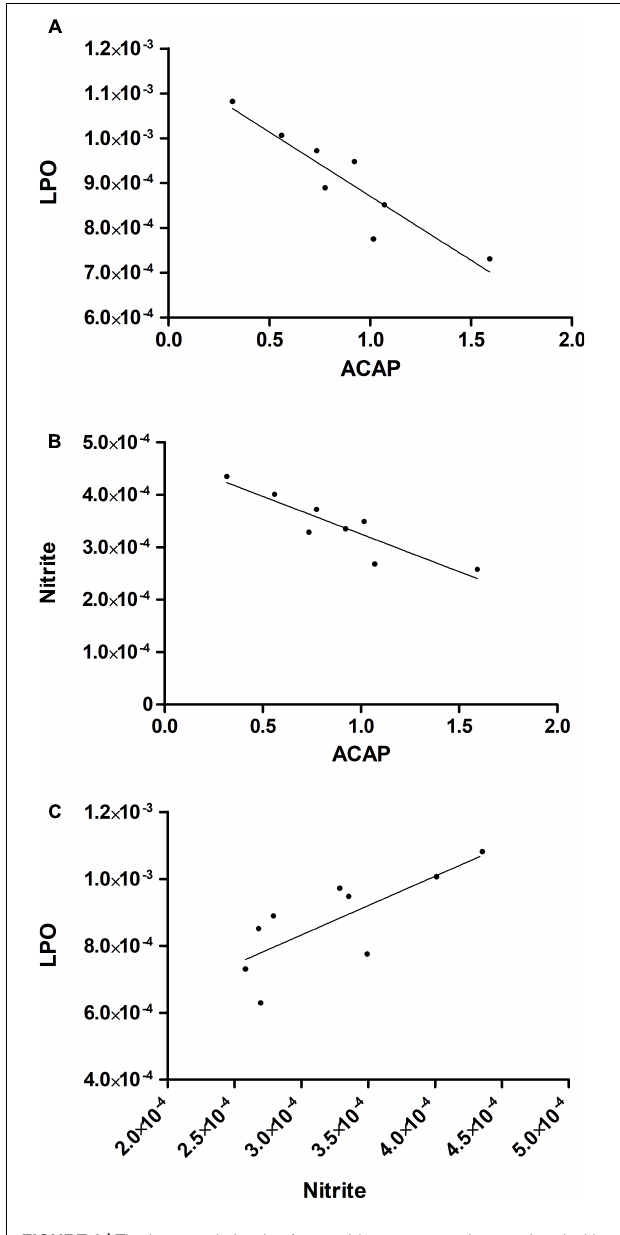
FIGURE 6 | The increase in levels of pro-oxidant measures is associated with a decrease in total antioxidant capacity. The results are expressed by the intersection between the correlated data. (A) Negative correlation between ACAP and malondialdehyde levels; (B) negative correlation between ACAP and nitrite levels; and (C) positive correlation between malondialdehyde and nitrite levels. The analysis was performed by Pearson’s